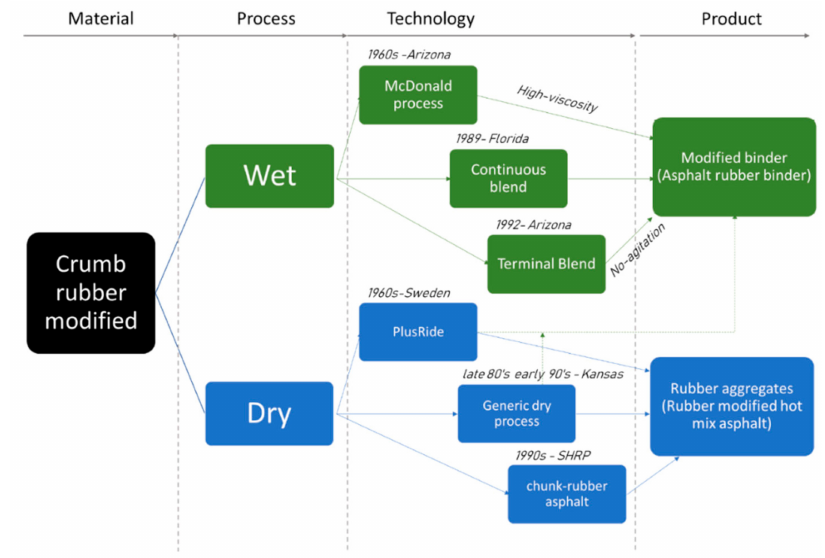
Figure 1. Principal materials, processes, technologies, and products for the use of reclaimed rubber in road materials. Note: Greenbook (2006) proposes three types of production processes: (i) wet process; (ii) dry process; (iii) terminal blend